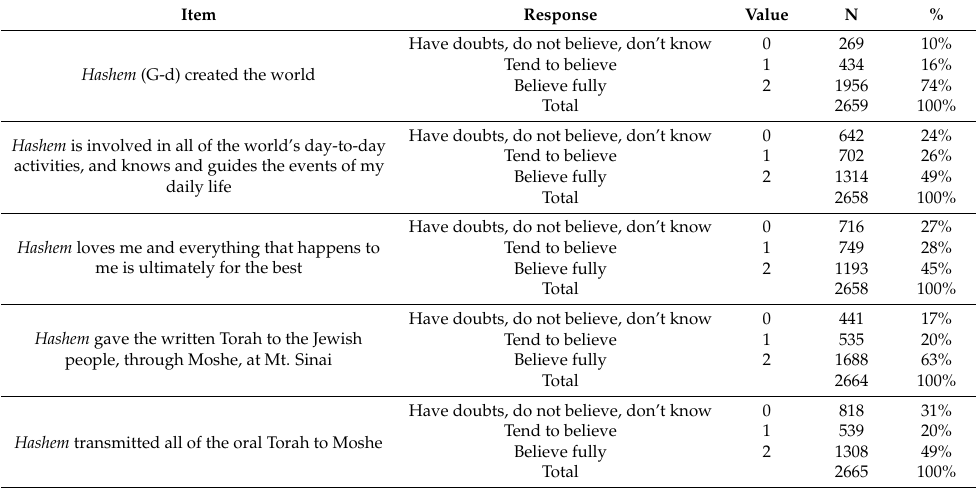
Table 3. Items in index of Orthodox Jewish beliefs.